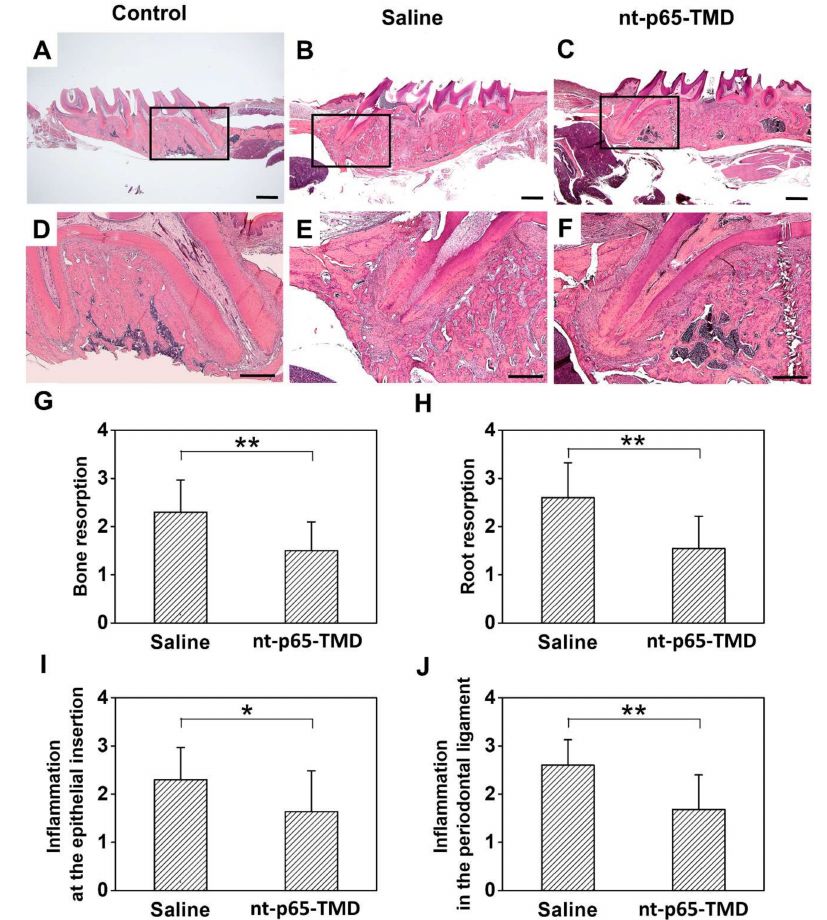
Figure 4. Histological analysis of replanted rat maxillary first molars 4 weeks after replantation. ( A , D ) Control group: The teeth without extraction and replantation. Inflammatory root resorption and bone resorption was not observed. ( B , E ) Saline group: The extracted teeth were replanted after storing in 0.9% physiological saline for 5 min. A large number of inflammatory cells were observed, and the apical third was lost by severe inflammatory root resorption. ( C , F ) nt-p65-TMD group: Localized root resorption and partial recovery of periodontal ligament and fibroblasts were observed ( G – J ) Evaluated scored, expressed as mean ± standard deviation, for ( G ) bone resorption, ( H ) root re- sorption, ( I ) inflammation at the epithelial insertion, and ( J ) inflammation in the periodontal